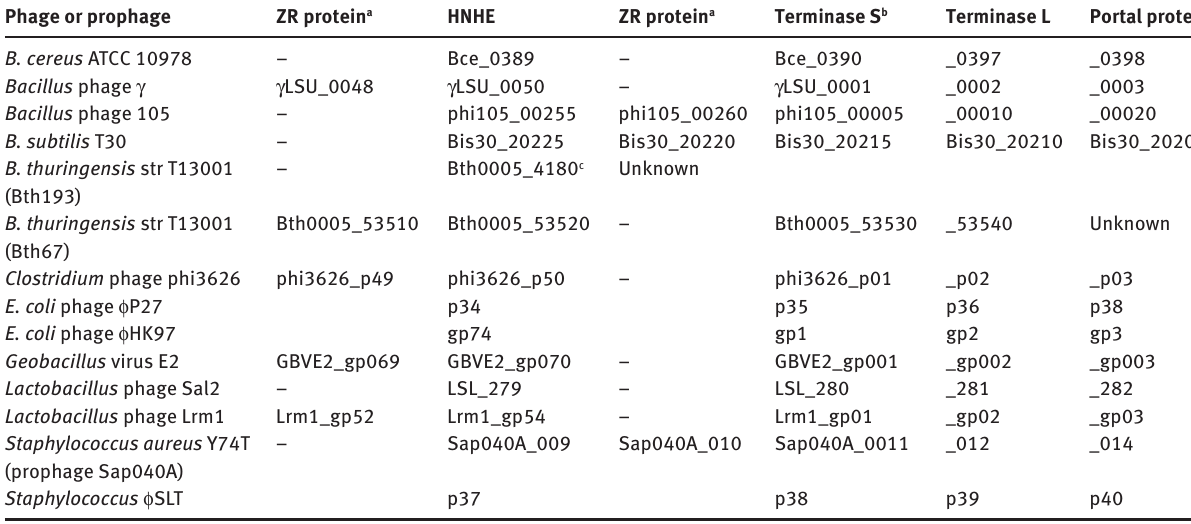
Table 2: Genes (ORFs) in proximity to the phage- or prophage-encoded HNH NEases.